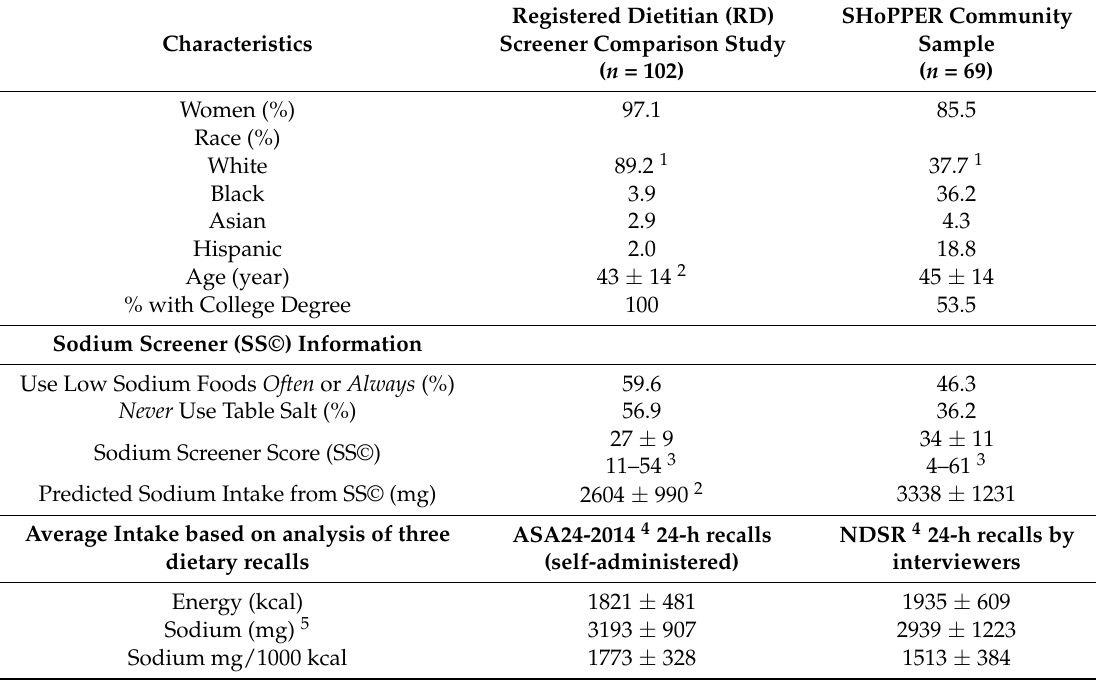
Table 1. Demographic characteristics and dietary estimates based on the Sodium Screener© and averaged 24-h recalls in two different study samples.